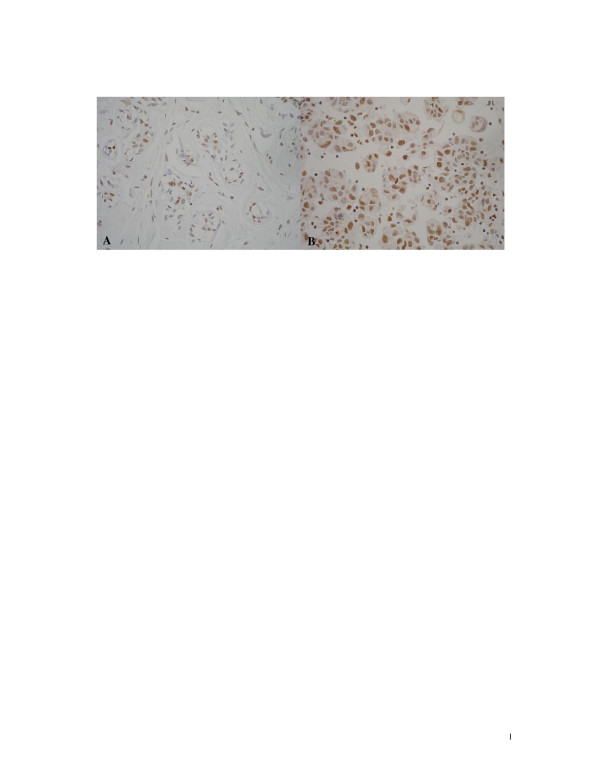
The differential expression of Fra-1 protein in breast carcinomas. Fra-1 protein immunostaining was weak in adjacent peritumoural tissues and positive reactivity restricted to nuclear (A), but strong in poorer differentiated region in the same section and positive reactivity presented in nuclear and cytoplasmic simultaneously (B). ×400 magnification.